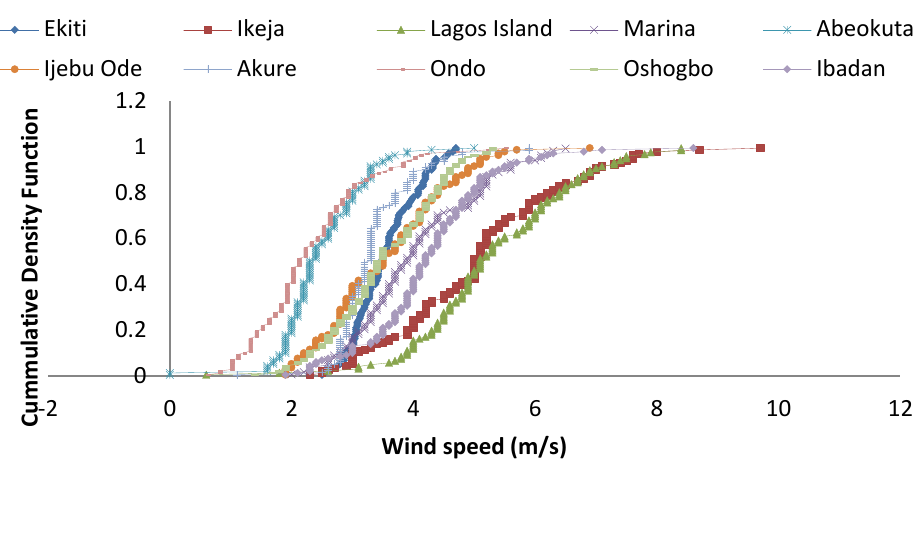
Figure 11. Wet Season’s PDF Plots of all the